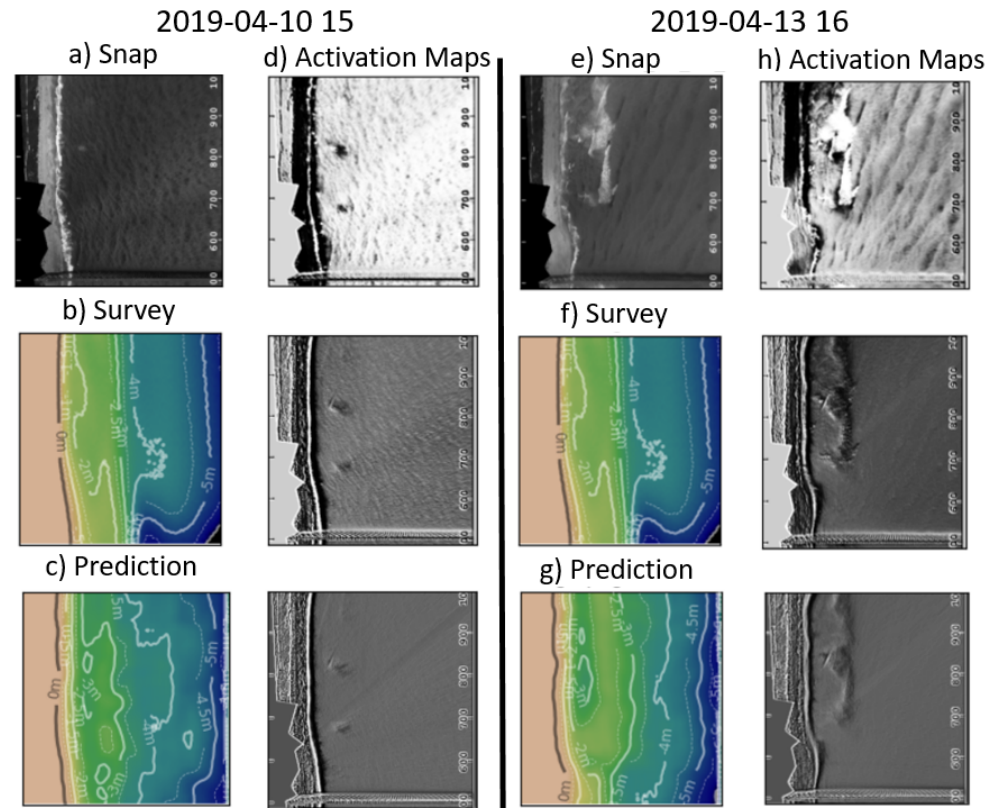
Figure 9. Activation maps from a single ensemble window are shown for the northernmost section for the example shown in transects three and four in Figure 4 and detailed in Figures 7 and 8. ( a ) shows the snap image for the labeled date. ( b ) shows the survey contours. ( c ) shows the instant prediction for that ensemble window. ( d ) shows three activation maps that emphasize the information that the network is keying off of to make its prediction. ( e ) shows the snap image for the labeled date. ( f ) shows the survey contours. ( g ) shows the instant prediction for that ensemble window. ( h ) shows three activation maps that emphasize the information that promotes a response in the